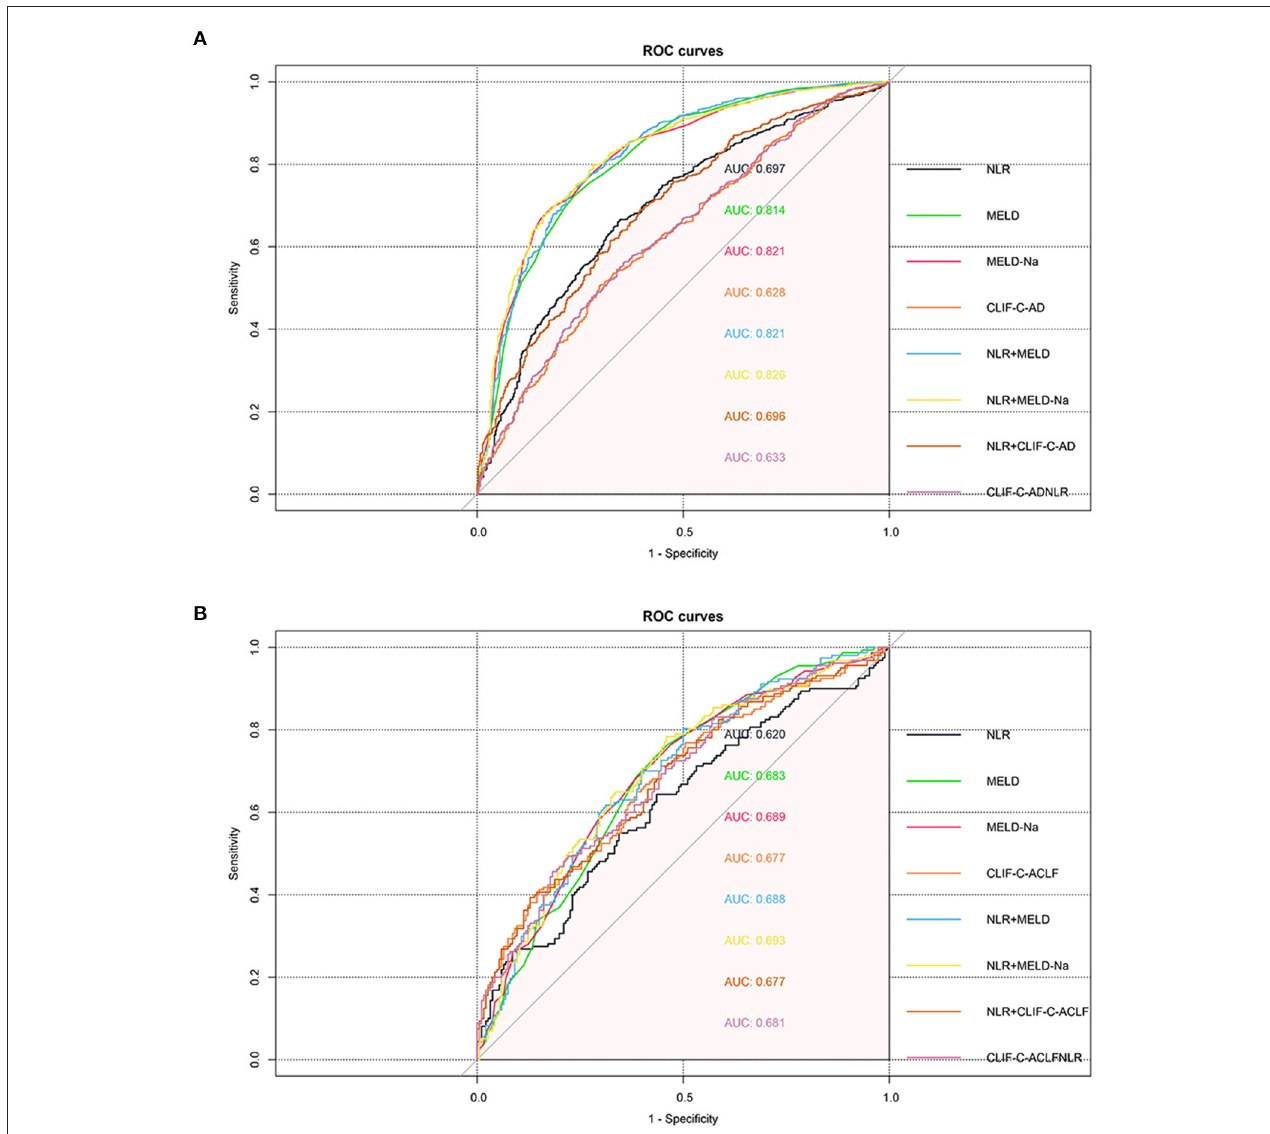
FIGURE 6 | Predictive ability of parameters for 90-day transplant-free mortality. ROC curve and AUC were calculated for neutrophil-to-lymphocyte ratio (NLR), MELD, MELD-Na, CLIF-C AD, CLIF-C ACLF, and and federated parameters by using the R package “pROC.” The cirrhotic patients with AD (A) and ACLF (B)